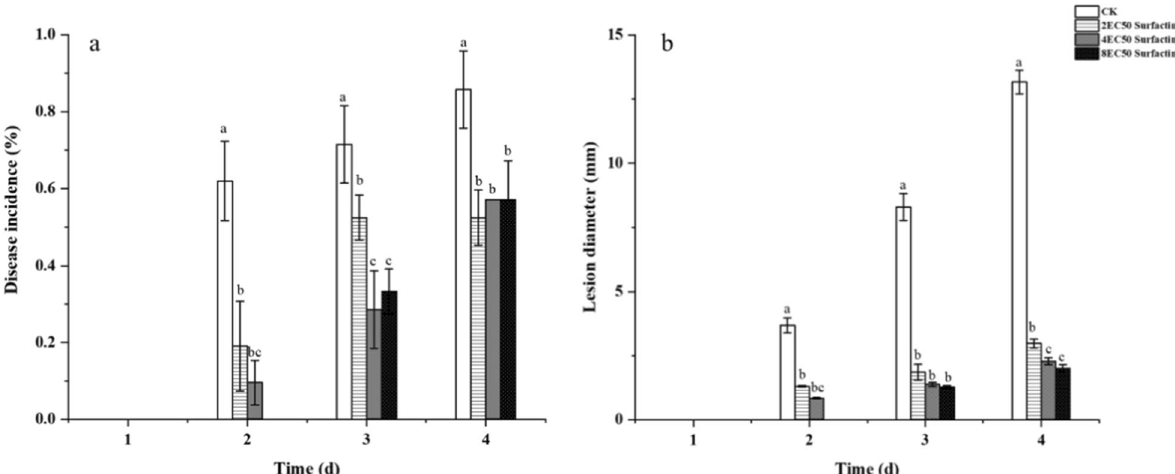
Fig. 4 Disease incidences of winter jujube inoculated by gray mold treated with surfactin at different concentrations: a percentage of disease incidence and b lesion diameter of gray mold patches on winter jujube. The error bars represent the SEs of the three replicates